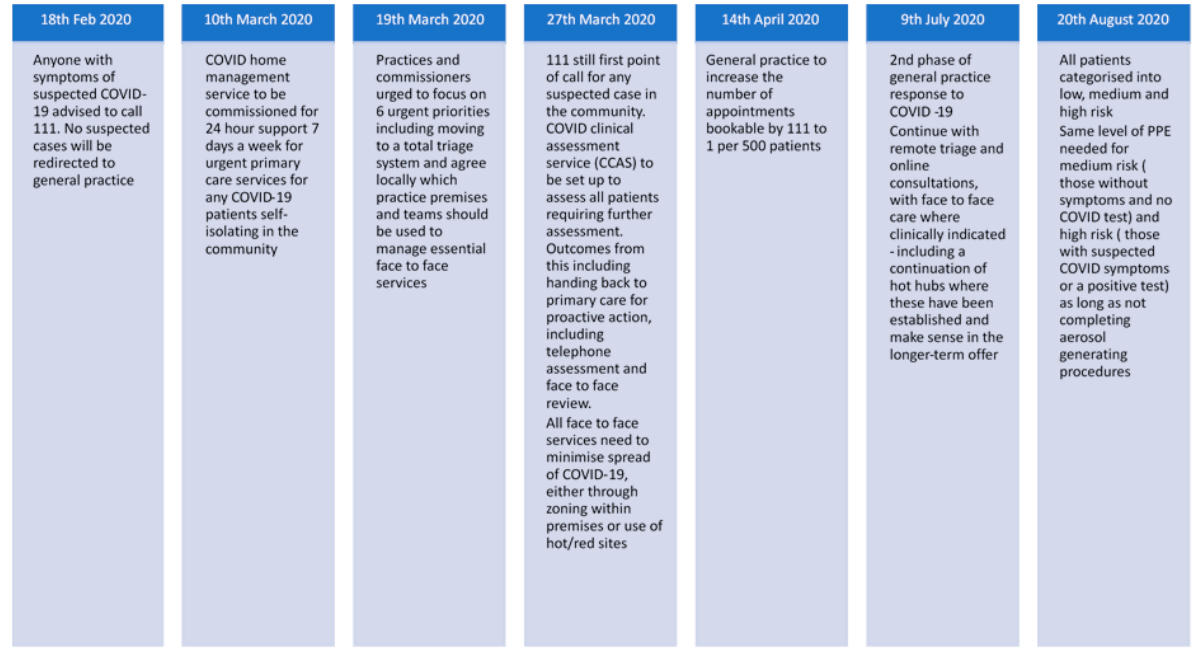
Figure 1. Timeline of NHS England suggested management of suspected coronavirus disease 2019 (COVID-19) within the community [5,11–16].